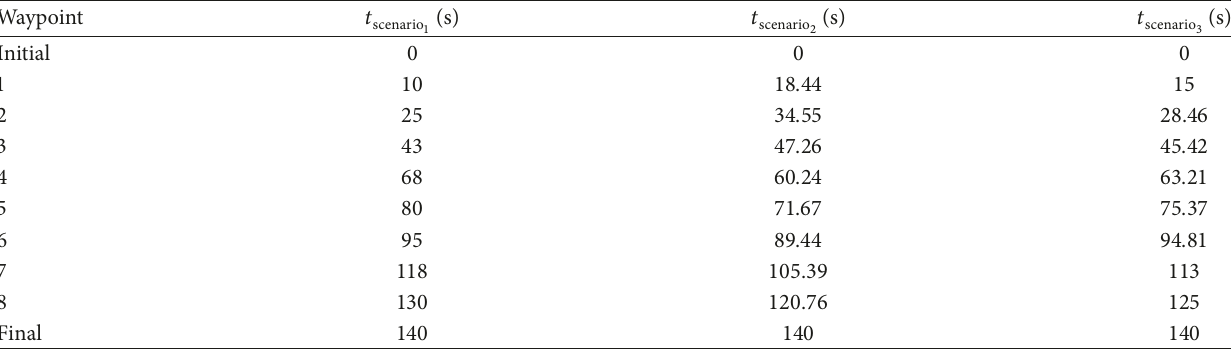
Table 8: Waypoints configuration with their optimal overfly-times schedule.